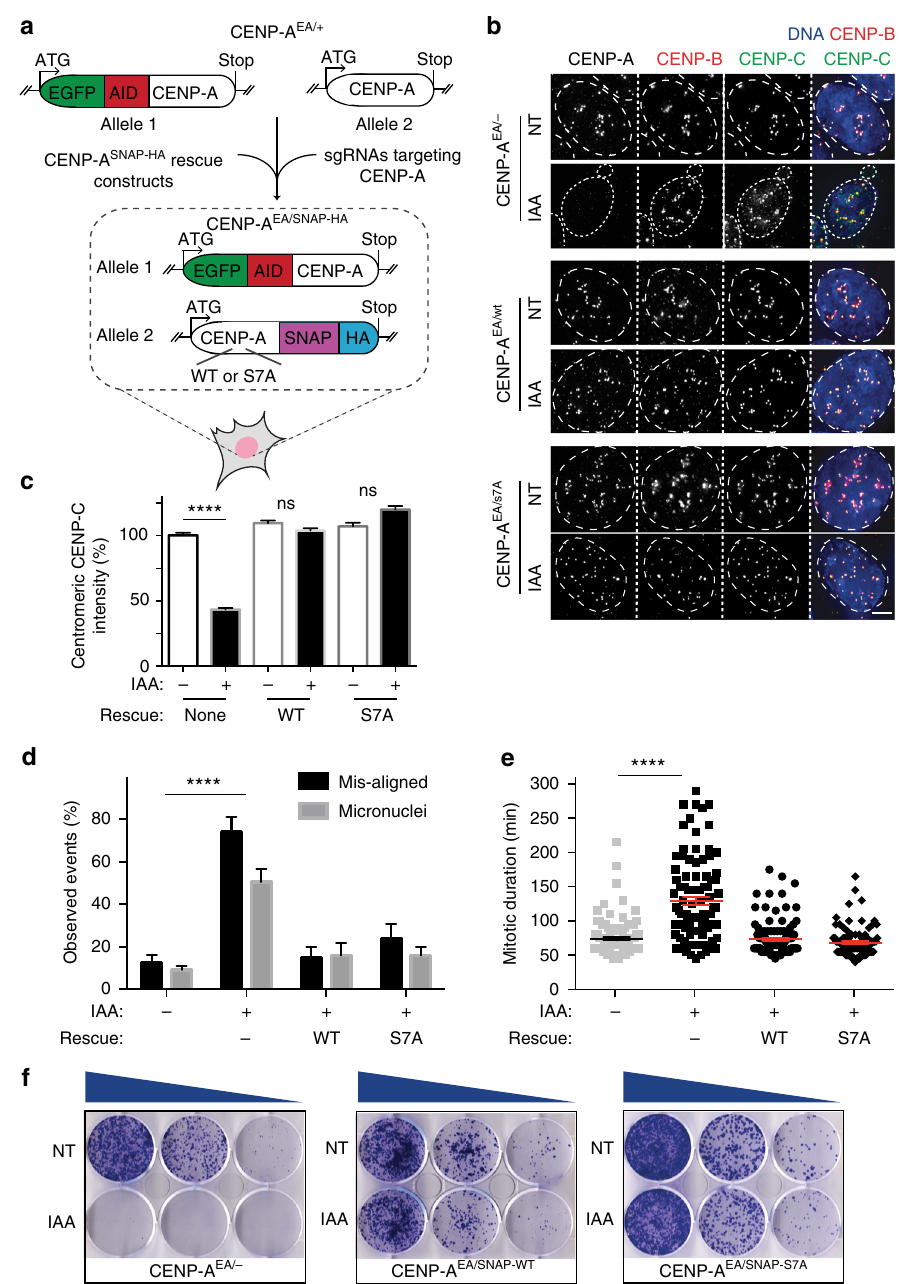
Fig. 2 Endogenous CENP-A un-ph S7 does not affect centromere function. a Schematics representing the strategy used for the generation of the DLD-1 cell line. b Representative immuno fl uorescence images showing the localization of CENP-A and CENP-C in the indicated cell lines (IAA treatment for 24 h). Scale bar = 5 µ m. c Quanti fi cation of CENP-C levels of the experiments in b . Error bars represent the SEM of three independent experiments. Unpaired t -test: **** p < 0.0001. d Quanti fi cation of mitotic errors in the indicated cell lines calculated by live-cell imaging observation after 2 days of IAA treatment. Error bars represent the SEM of three independent experiments. ANOVA test **** p < 0.0001. e Quanti fi cation of mitosis duration in the indicated cell lines. Each individual point represents a single cell. Time in mitosis was de fi ned as the period from NEBD to chromosome decondensation. Error bars represent the SEM of three independent experiments. Unpaired t -test: **** p < 0.0001. f Representative images of crystal violet-stained colonies from the